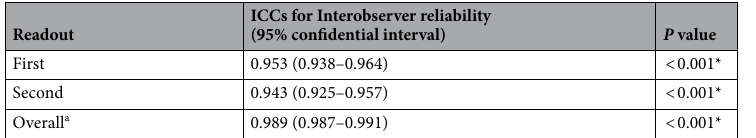
Table 2. Interobserver reliability in the first and second readouts. ICC = Intraclass correlation coefficient. Data are shown as mean ± standard deviation. * P < 0.05. a ICCs for the data set of 518 total grades (209 images × 2